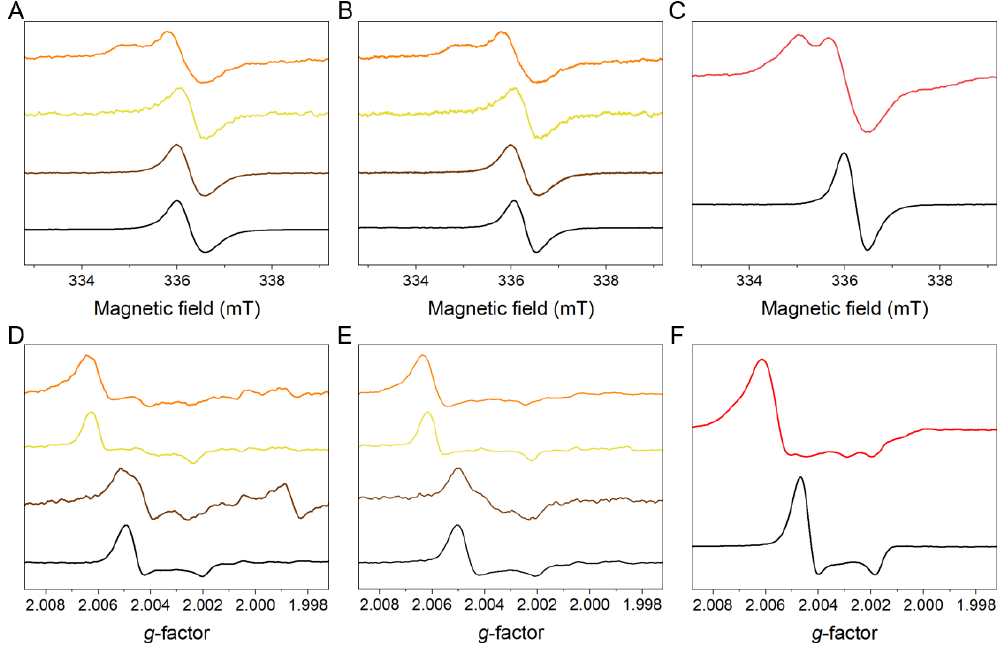
Figure 3. EPR spectra of the studied melanins obtained in X-band ( A – C ) and W-band ( D – F ). ( A , D ) show spectra of melanosomes, whereas ( B , E ) show spectra of melanin nanoaggregates. Color lines indicate the following samples: orange (red hair), yellow (blond hair), brown (chestnut hair) and black (black hair). ( C , F ) show spectra of synthetic melanin models used as standards: Cys-L-DOPA melanin (red) and DOPA melanin (black).